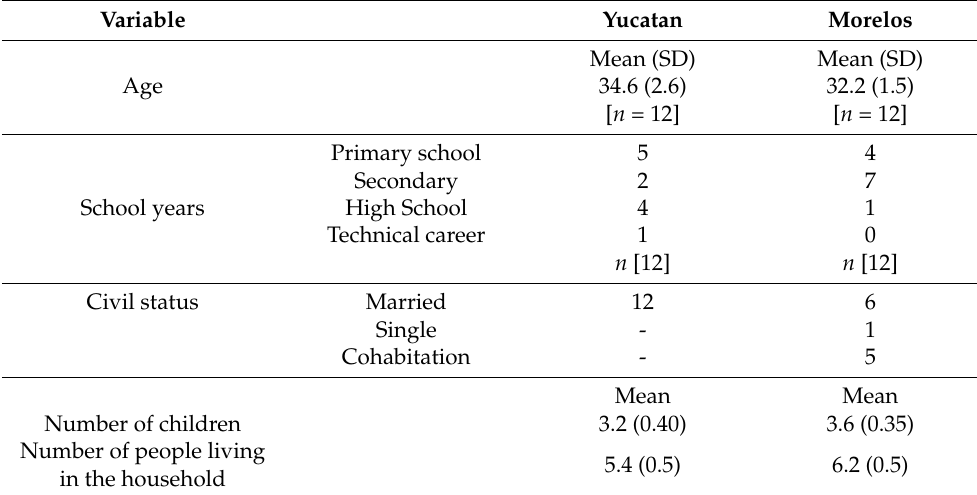
Table 1. Main sociodemographic characteristics of PCs.